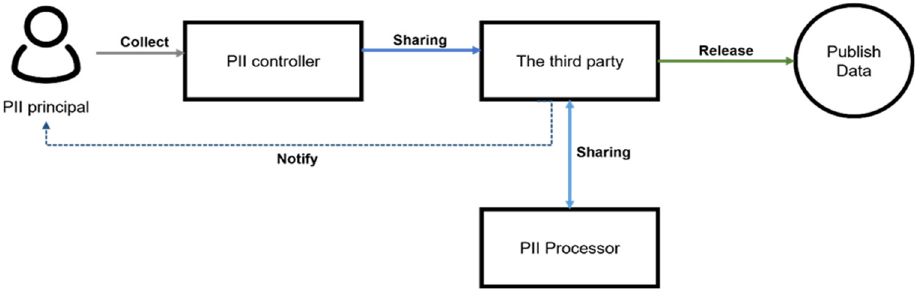
Figure 3. Privacy model of a centralized contact tracing system.